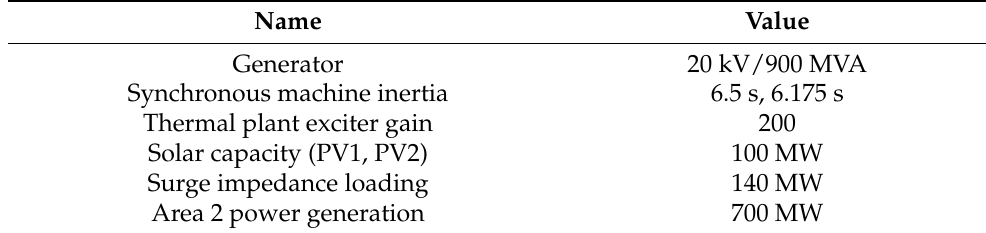
Figure 4. This modified Kundur system has four synchronous machines and two aggregated residen- tial PV systems. Table 1. Parameters of the benchmark system under